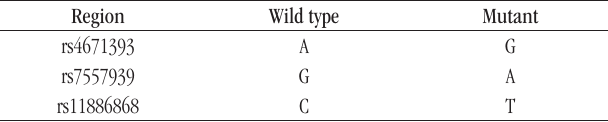
taBLE 1 − Polymorphisms and regions of the BCL11A gene